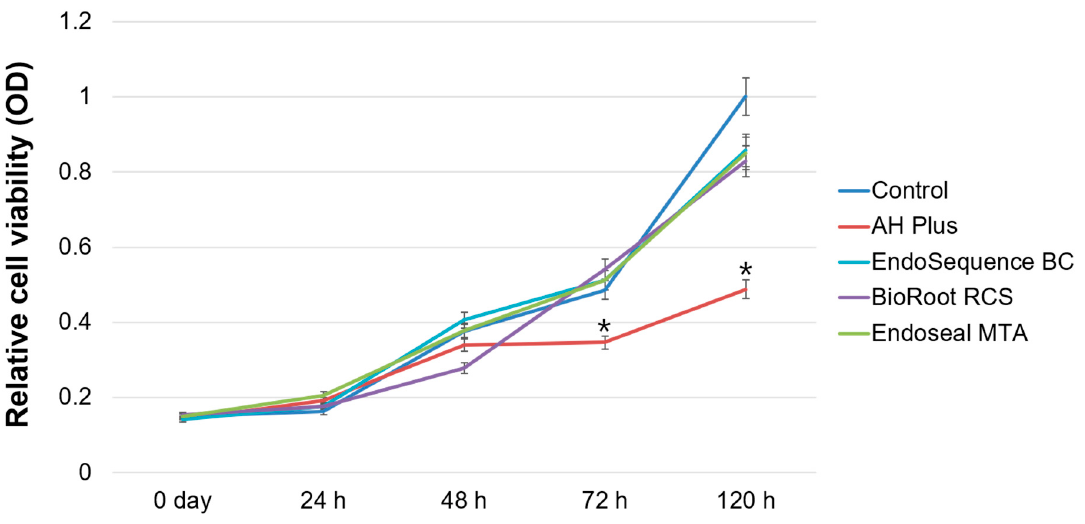
Figure 2. Relative cell viability rate based on a methyl-thiazoldiphenyl-tetrazolium (MTT) assay. Asterisks indicate statistically significant differences between the control group and experimental groups.